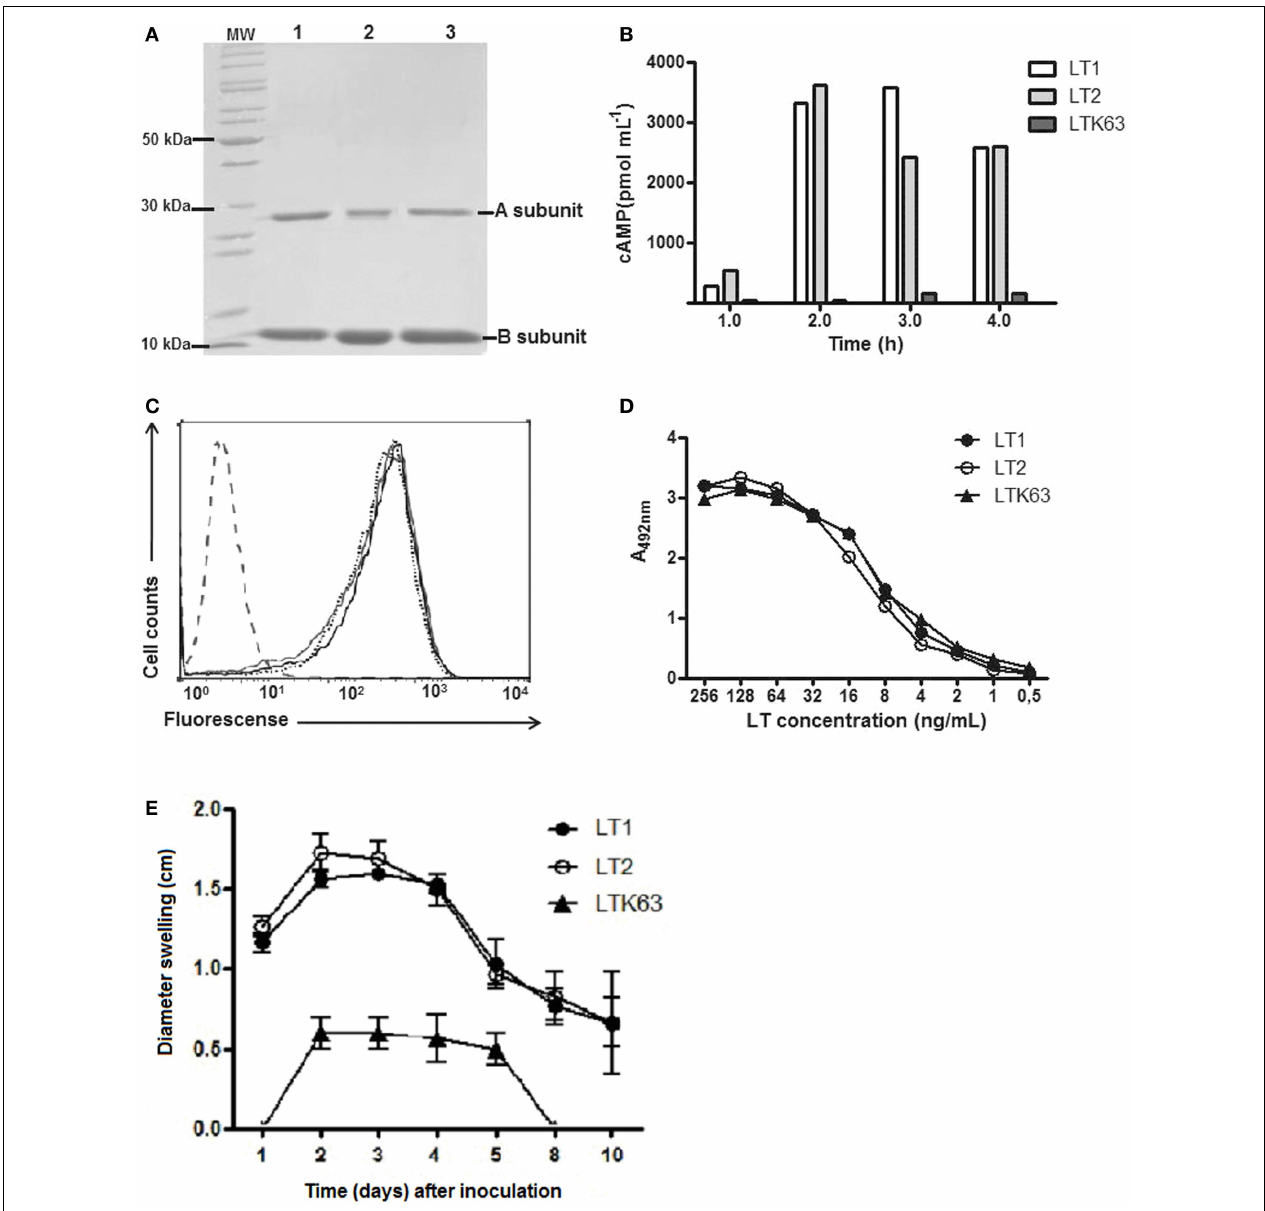
emitted fluorescence in a flow cytometer. Samples: LT1 (dotted line); LT2 (black line), and LTK63 (gray line). UntreatedY-1 cells are indicated by the dashed line on the left side of the figure. (D) Receptor binding activities of the purified LT derivatives in GM1-ELISA. Reactions were developed with mouse anti-LT serum and peroxidase-conjugated anti-mouse IgG antibody. (E) Local edema formation in BALB/c mice ( n = 5) after i.d. injection of 1 µ g of the test LT forms.The experiment was independently performed three